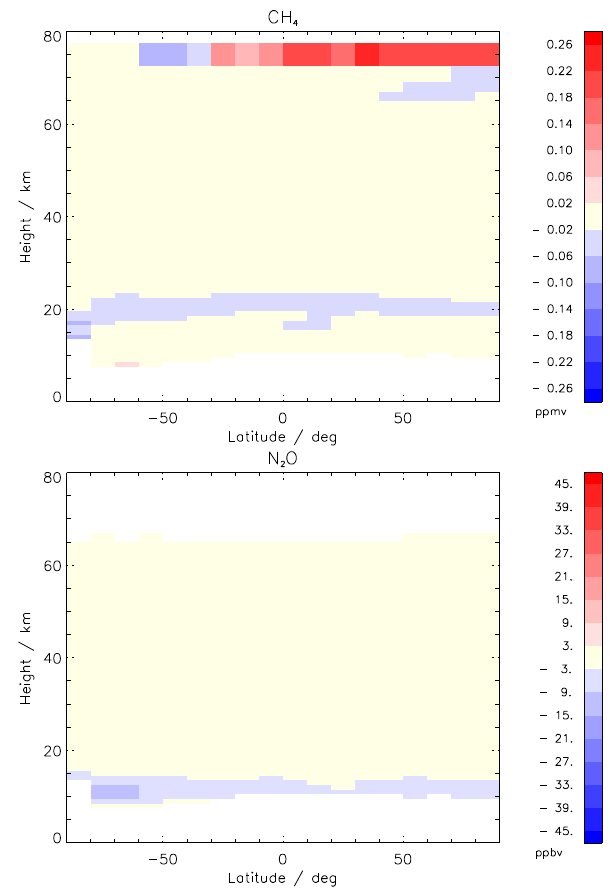
1 Figure 5. As Fig. 3, but difference retrieval with Tikhonov con- straint and relaxed constraint between neighbouring microwindows minus reference with old